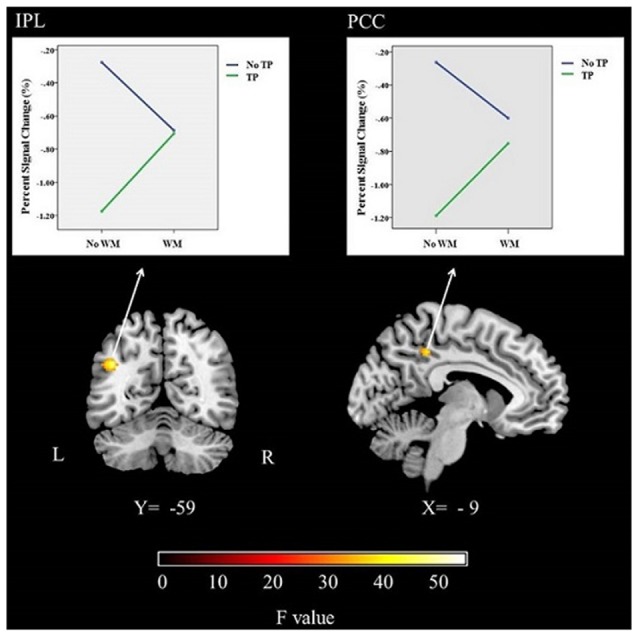
The brain activations and related graphs of the interaction of time perception and working memory for the whole group (p < 0.05, FWE corrected). IPS, Intraparietal Sulcus; PCC, Posterior cingulate cortex; L, Left; R, Right.